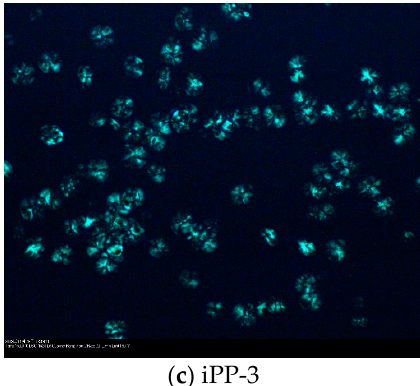
Figure 3. Morphologies of ( a ) iPP-1, ( b ) iPP-2 and ( c ) iPP-3 under a polarizing microscope.